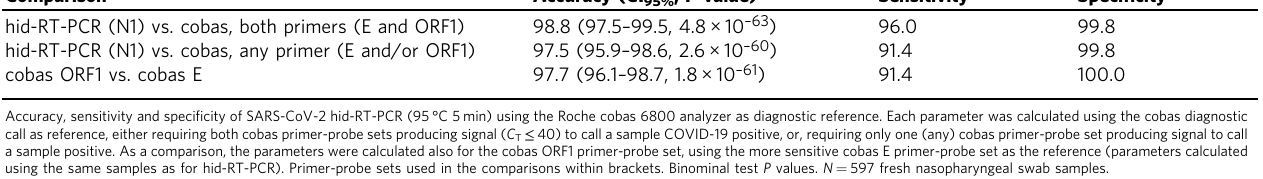
Table 3 Accuracy, sensitivity and speci fi city of SARS-CoV-2 hid-RT-PCR. Comparison